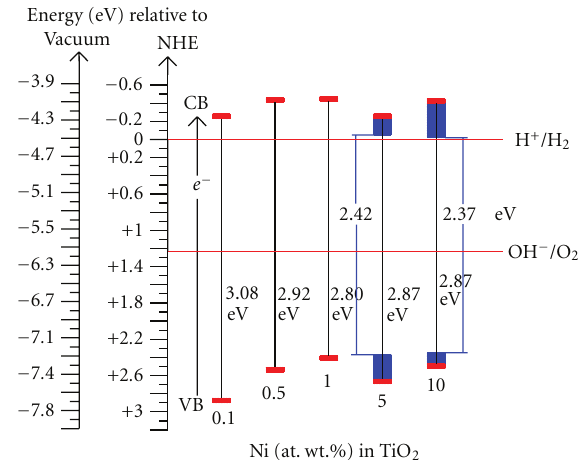
Figure 10: The electrochemical potentials (versus NHE) of band edges of Ni-doped TiO 2 (Ni = 0.1, 0.5, 1, 5 and 10 at. wt.%) powders (formed at 550 ◦ C for 6h) at pH